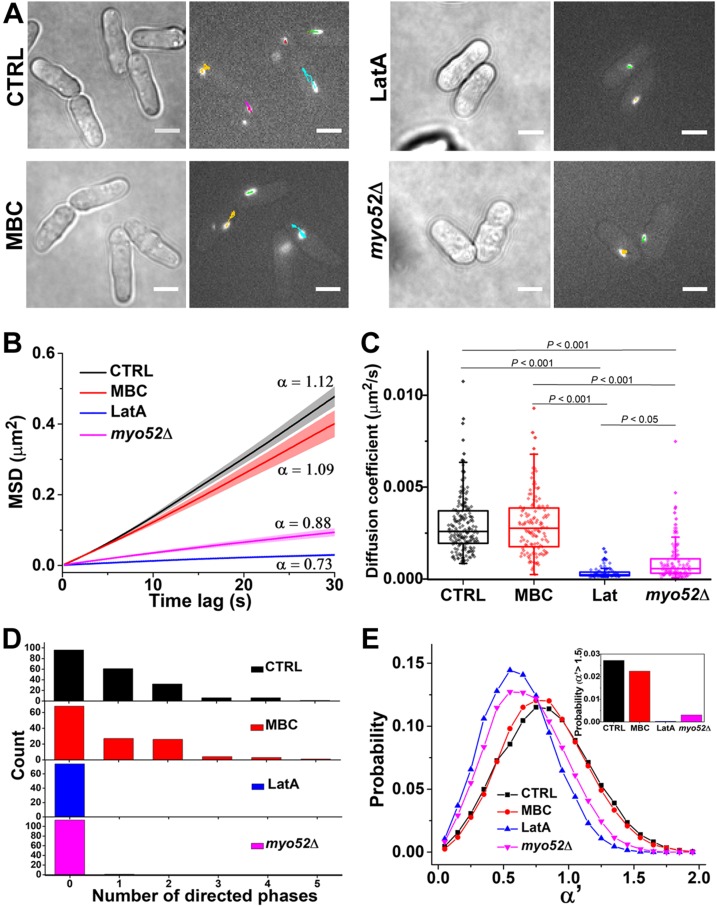
Comparison of cytoophidium dynamics in control, MBC-treated, LatA-treated, and myo52Δ cells. A) Representative bright-field and fluorescence micrographs show distinct dynamic behaviors under the different conditions. In the fluorescence images, the trajectory of each cytoophidium during 5 min imaging is marked by colored lines. Scale bars, 5 µm. B) Plot of average MSD curves as a function of time lag. Error bars represent se. Each MSD curve is calculated from 1 cytoophidium trajectory. Trajectories analyzed: control (n = 202), MBC (n = 129), LatA (n = 75), myo52Δ (n = 114). C) Comparison of diffusion coefficients of cytoophidia under each condition. Each diffusion coefficient was determined by linear fitting of the MSD curve for each trajectory. Diamonds represent samples of diffusion coefficients. Box plots show median and interquartile range. All significant differences are indicated by P values, which were calculated using 1-way ANOVA and Tukey’s post hoc test. Values of P < 0.05 were considered statistically significant. D) Distribution of the directed phases from each trajectory over the course of 5 min imaging. Directed phases: control (175), MBC (108), LatA (0), myo52Δ (1). E) Distributions of temporal exponent α′ of local trajectories (segments of 40 consecutive points along all the cytoophidium trajectories) under different conditions. Inset, the probability of α′ > 1.5: control (0.027), MBC (0.022), LatA (0.0003), myo52Δ (0.003). The number of temporal exponents α′ in (E): control (199987), MBC (137503), LatA (84658), myo52Δ (124285).